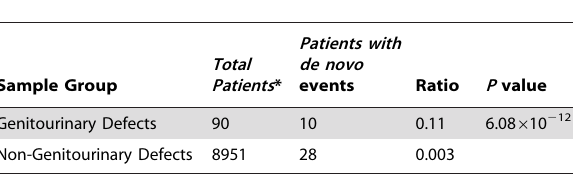
Table 7. De novo CMA detected events are more enriched in GU patients than in individuals without urogenital